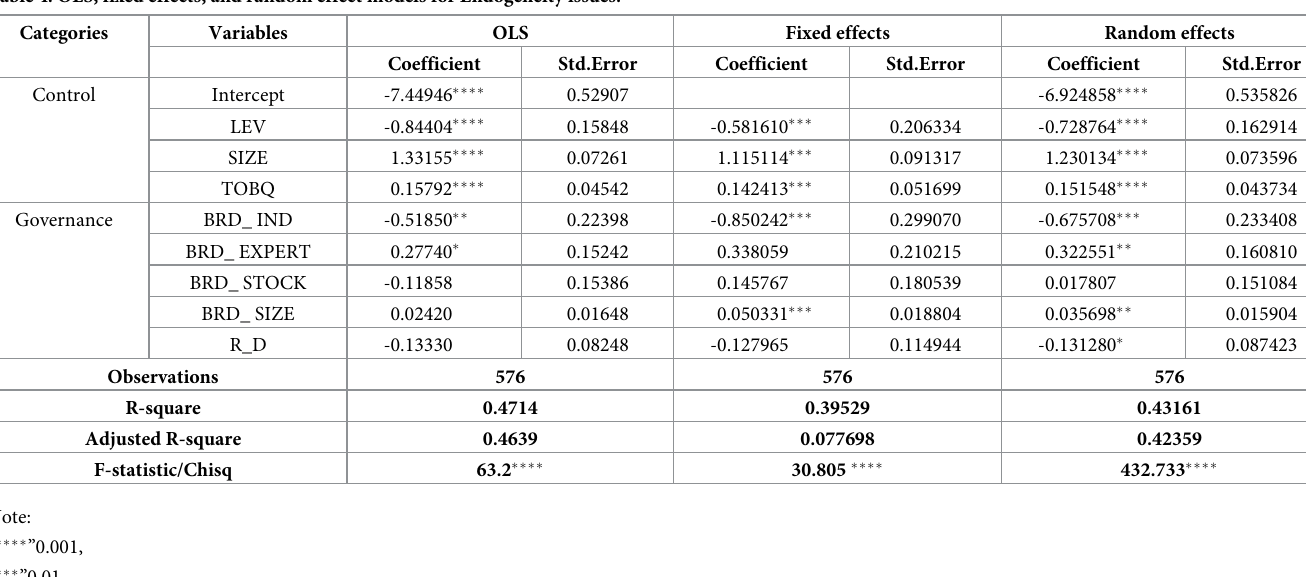
Table 4. OLS, fixed effects, and random effect models for Endogeneity